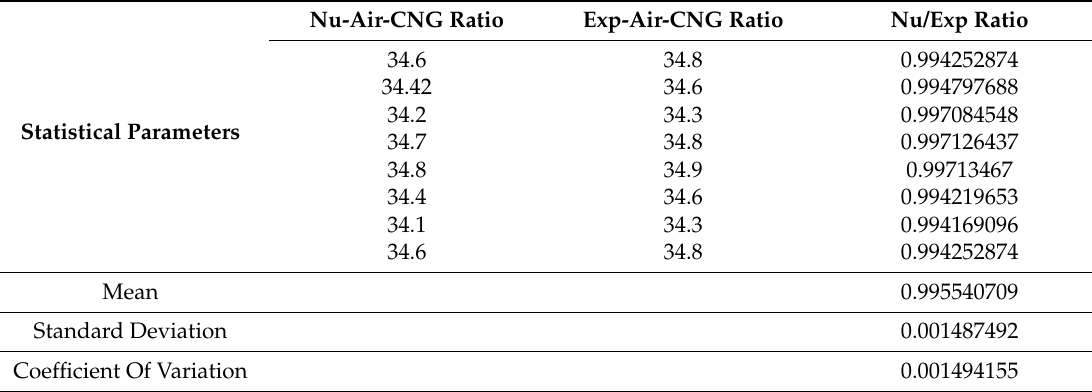
Table 7. Comparison between the experimental and numerical results inside the new mixer.